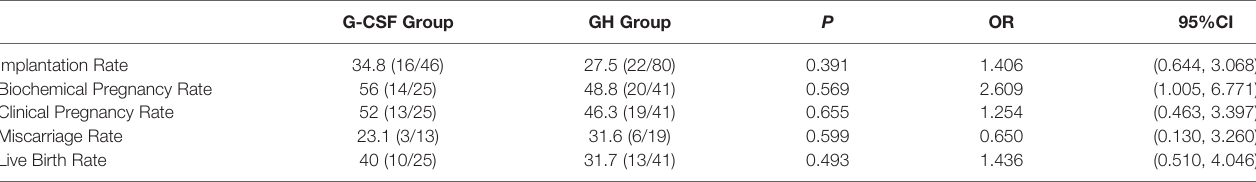
TABLE 2 | Comparison of implantation rate, biochemical pregnancy rate, clinical pregnancy rate, miscarriage rate, and live birth rate in the two